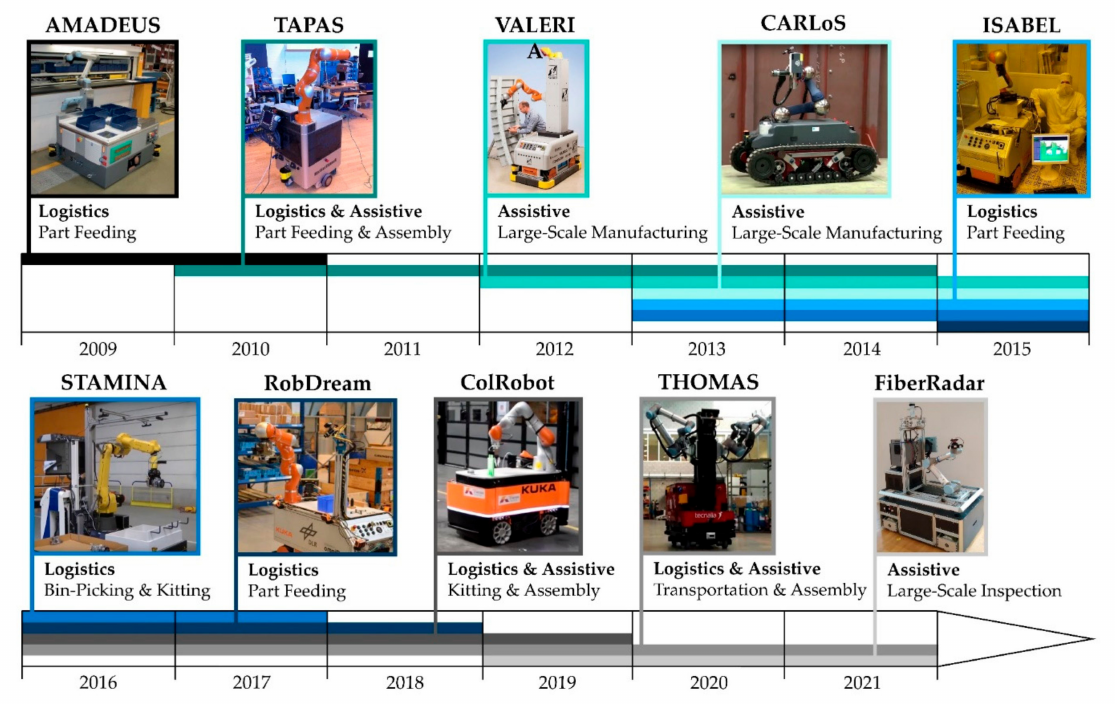
Figure 1. Related research projects from 2009 to